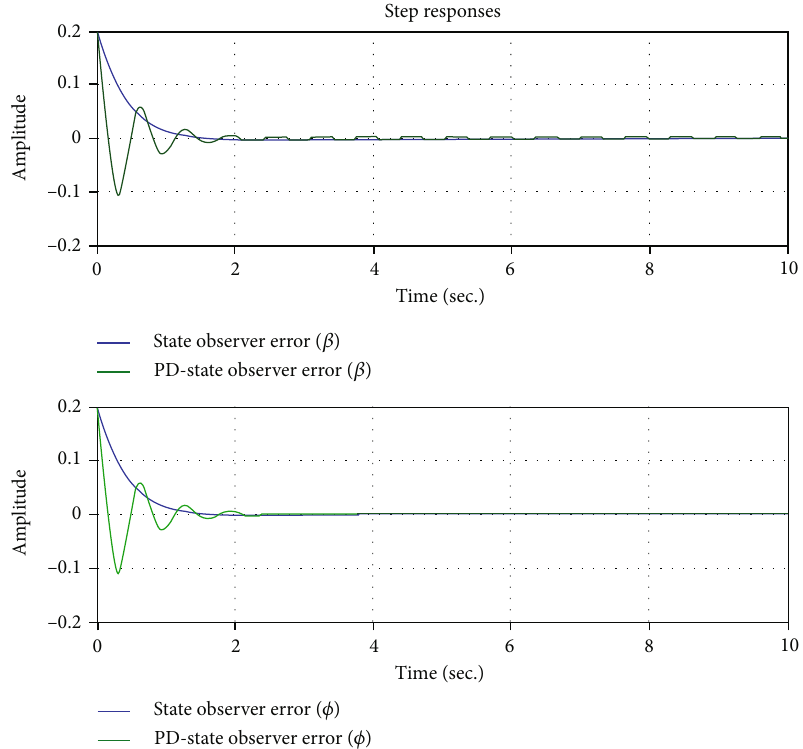
Figure 7: Simulations of state observer error with α = 10 I